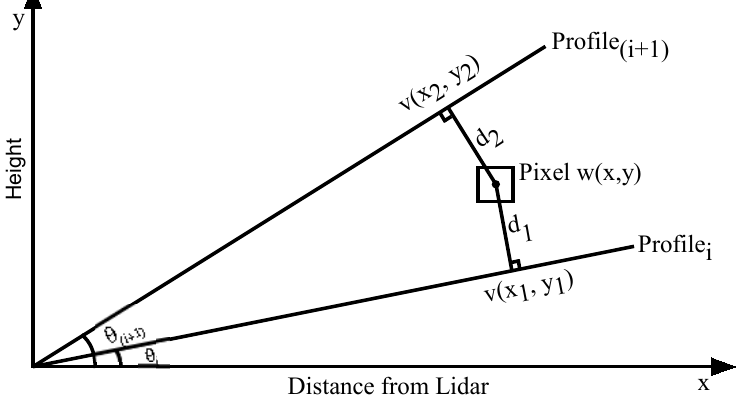
Figure 3. Construction of Cartesian 2D range-height-indicator (RHI) diagrams. A weighted logarithm range squared corrected signal (RSCS) value is calculated by a barycentric interpolation scheme between the LiDAR return signal profiles from successive scanning angles. Each pixel of the diagram represents atmospheric information at that